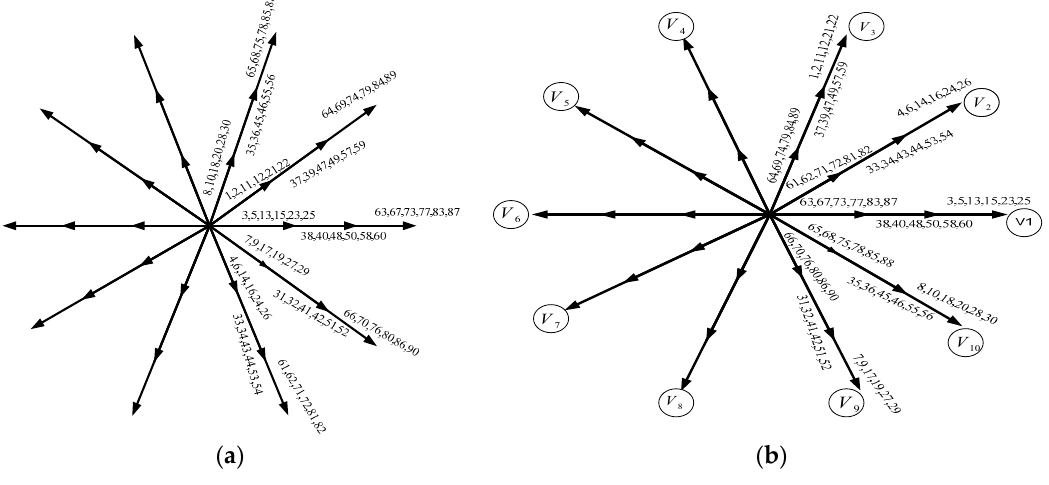
Figure 4. Phase-to-ground voltage output vectors in the subspaces ( a ) ( α − β ) ( b ) ( Z 1 − Z 2 ) .